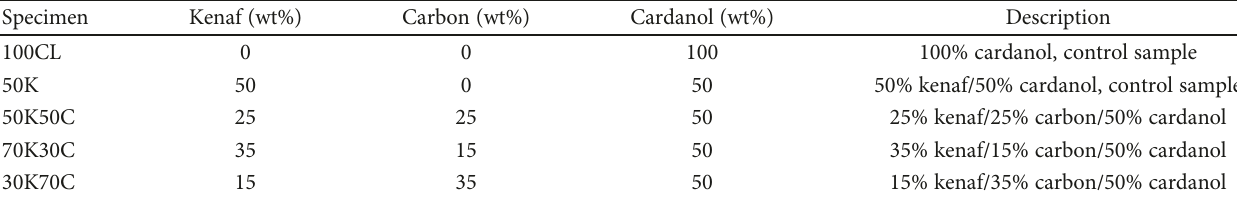
Table 1: Hybrid composite